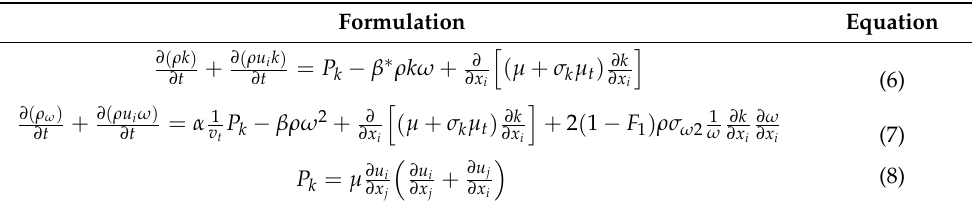
Table 5. Turbulence k- ω SST model